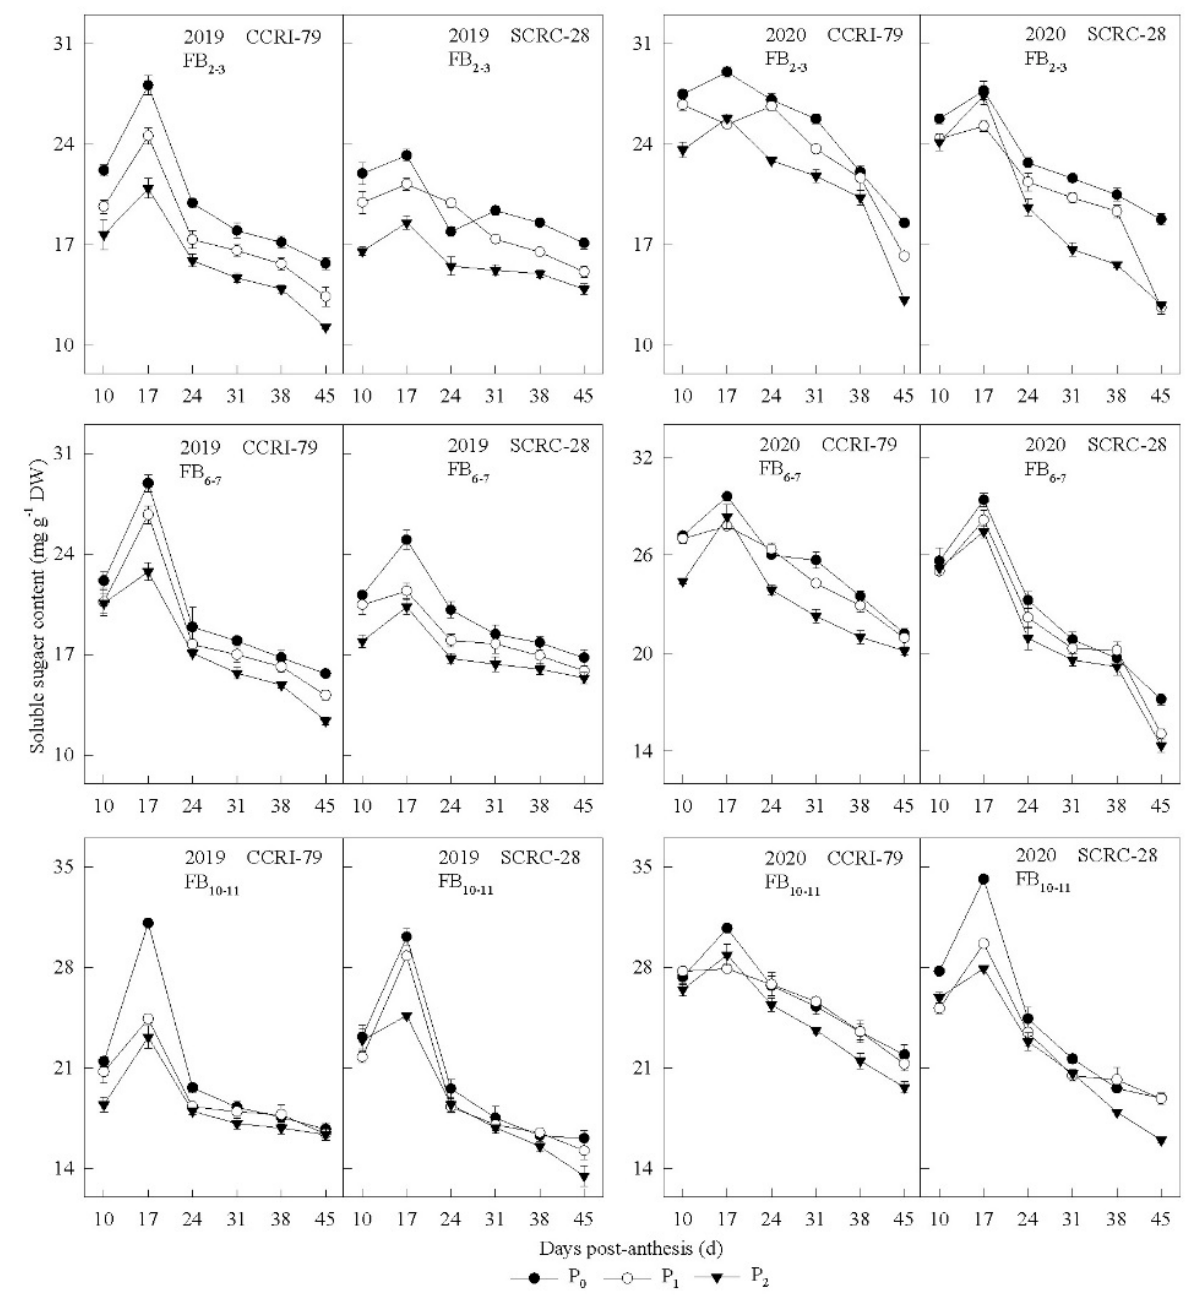
Figure 4. The effect of soil available phosphorus (AP) on the soluble sugar content of subtending leaves in 2019 and 2020 cotton − growing seasons. d: day. FB: fruiting branch. P 0 : 3 ± 0.5 mg kg − 1 . P 1 :